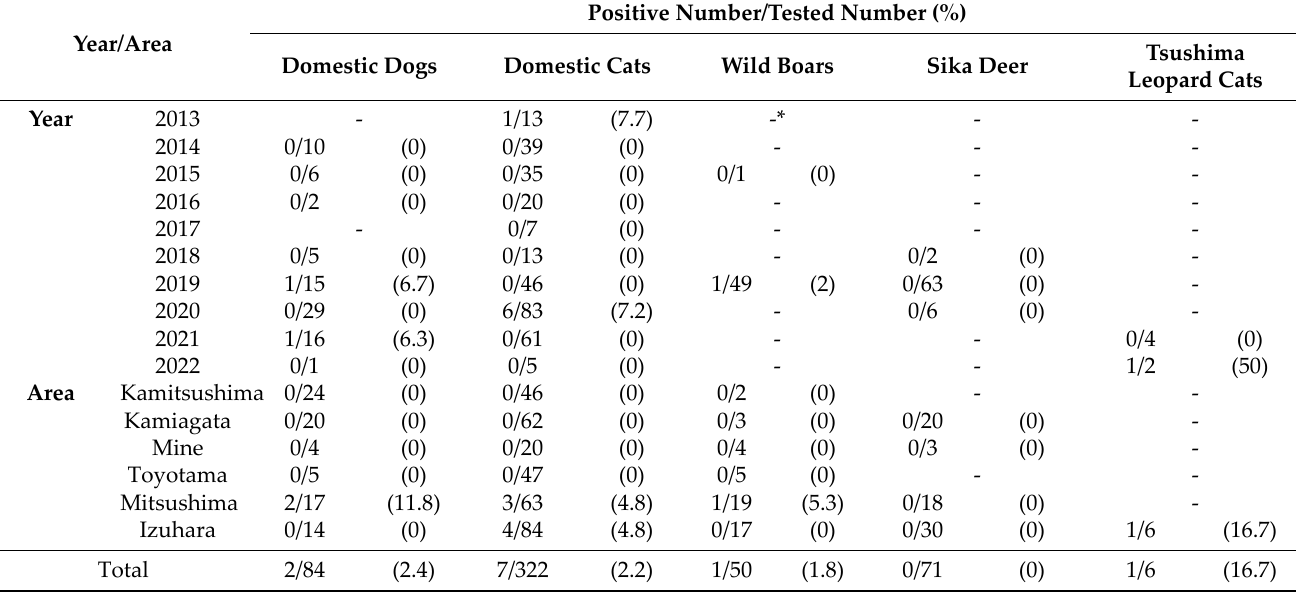
Table 3. Seroprevalence of SFTSV infection in animals by year and